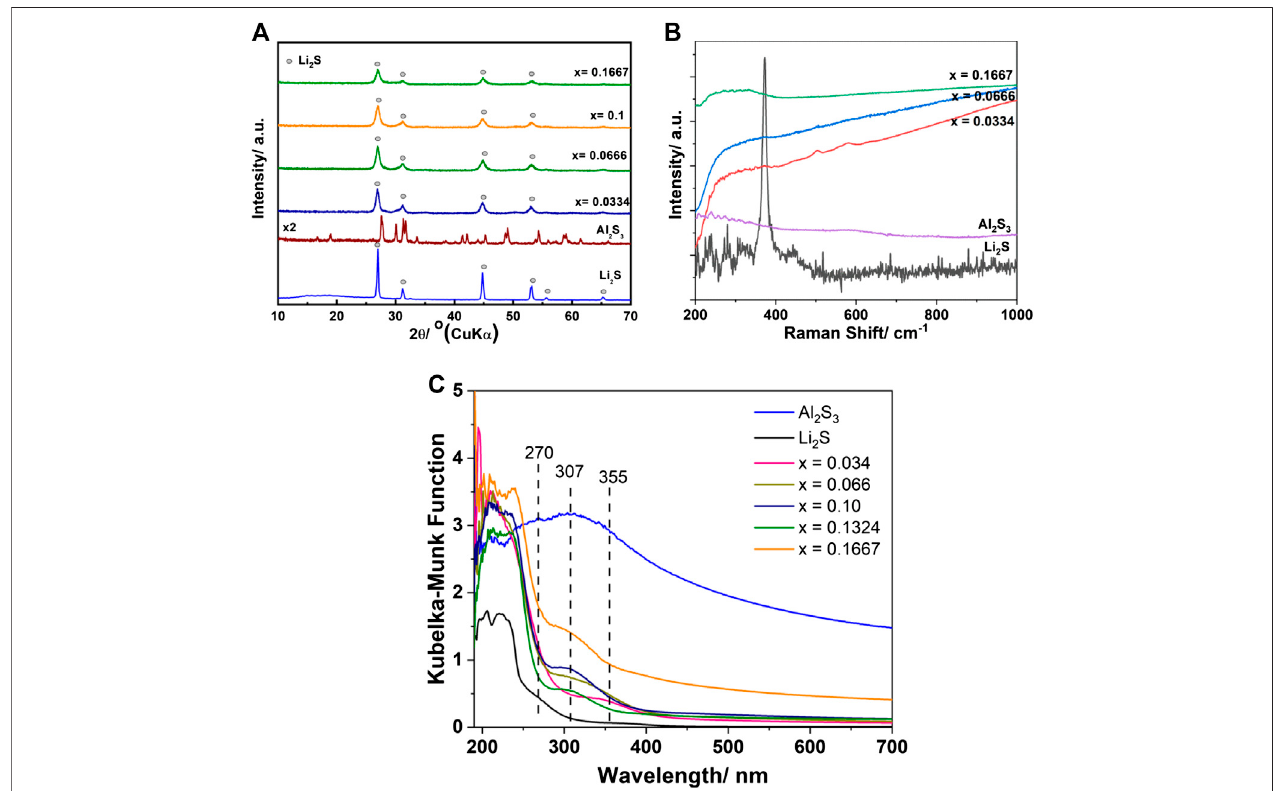
FIGURE 1 | Structure characterization of Li 0.1667) samples.